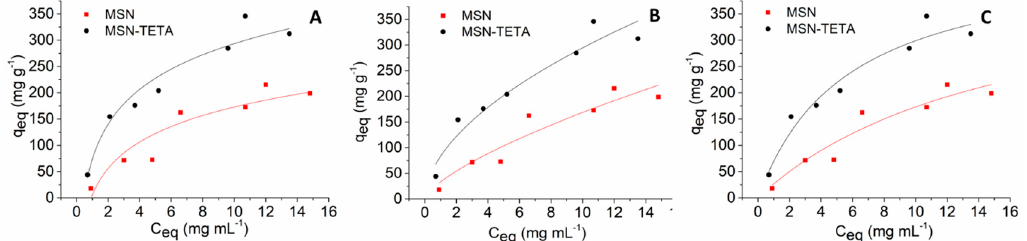
Figure 6. Adsorption isotherms (298 K) of SMZ on MSN and MSN-TETA fitted with Temkin ( A ), Freundlich ( B ), and Langmuir ( C ) models.